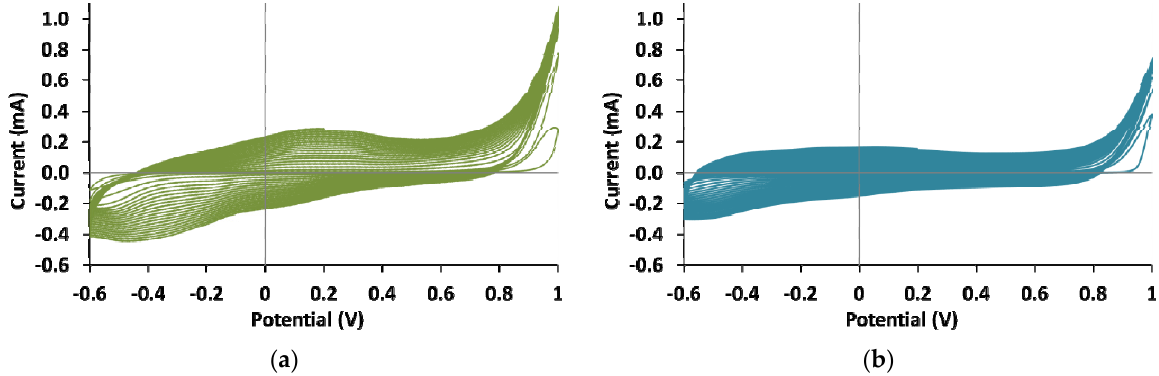
Figure 2. The cyclic voltammograms obtained during the electrosynthesis of PEDOT in the regime of cycling potential in the presence of the mixtures of PAMPSA/t-PASA (1:1) ( a ) and PAMPSNa/t-PASNa (1:1) ( b ). Table 1. Electrochemical parameters of different regimes of PEDOT electrosynthesis in the presence of various PEs and their